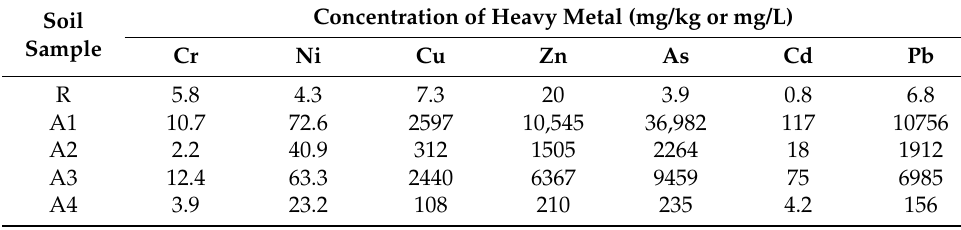
Table 2. Total concentrations of heavy metals in test soil samples in North Chungcheong Province, Korea, used in soil ecological risk assessments, as determined with inductively coupled plasma optic emission spectrometry